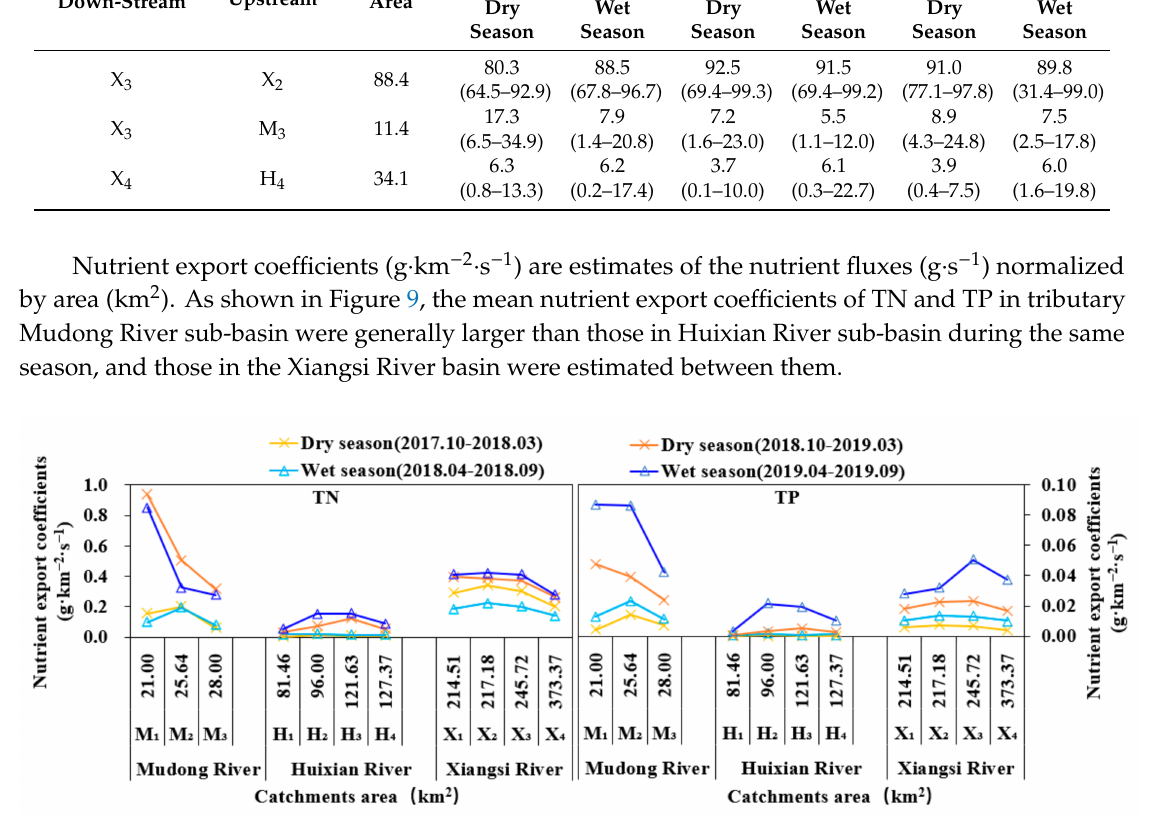
Figure 9. The mean nutrient export coe ffi cients of TN and TP for the eleven catchment scales in the dry and wet seasons.